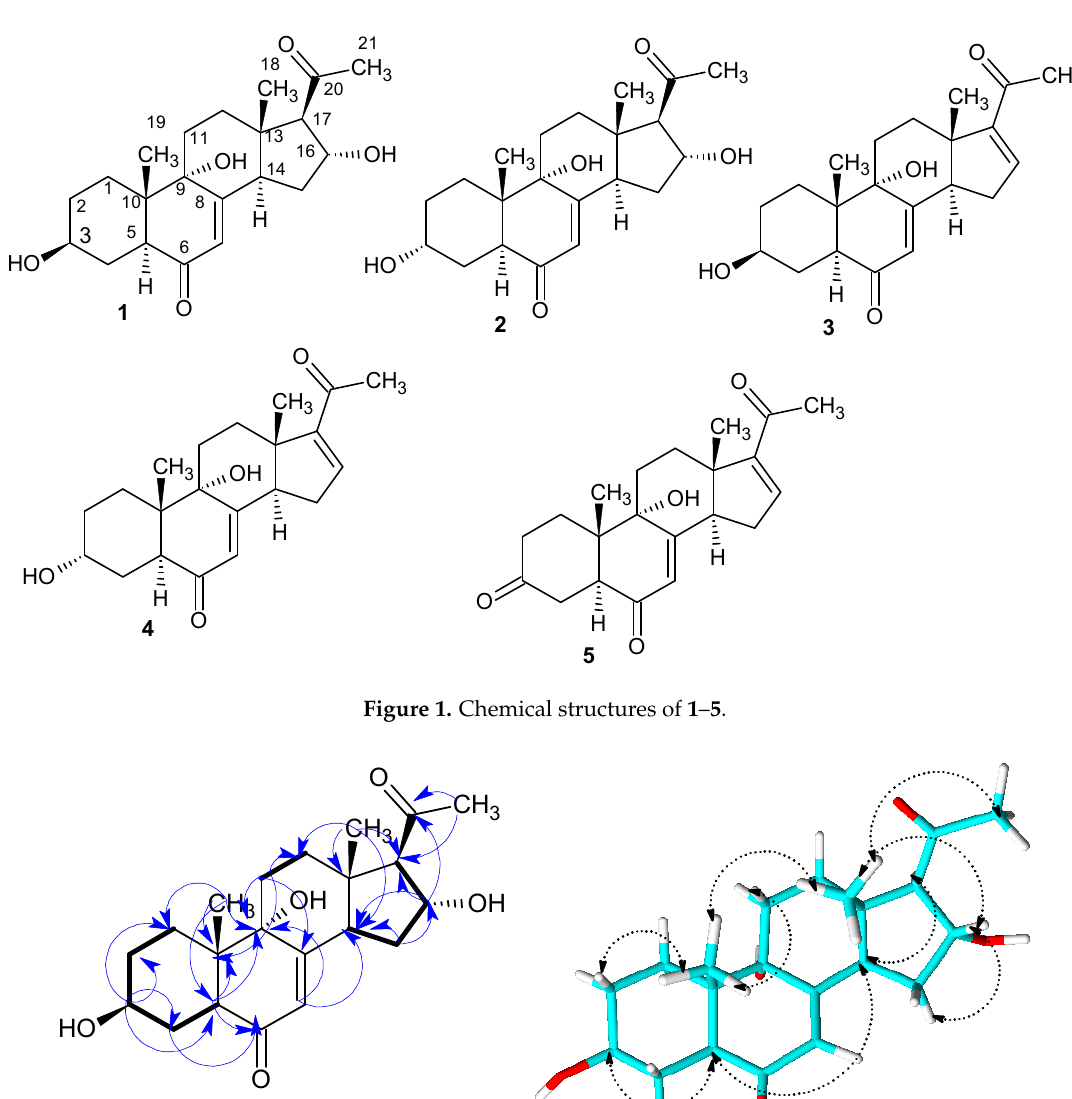
Figure 2. HMBC, COSY and ROSY correlations of 1 .